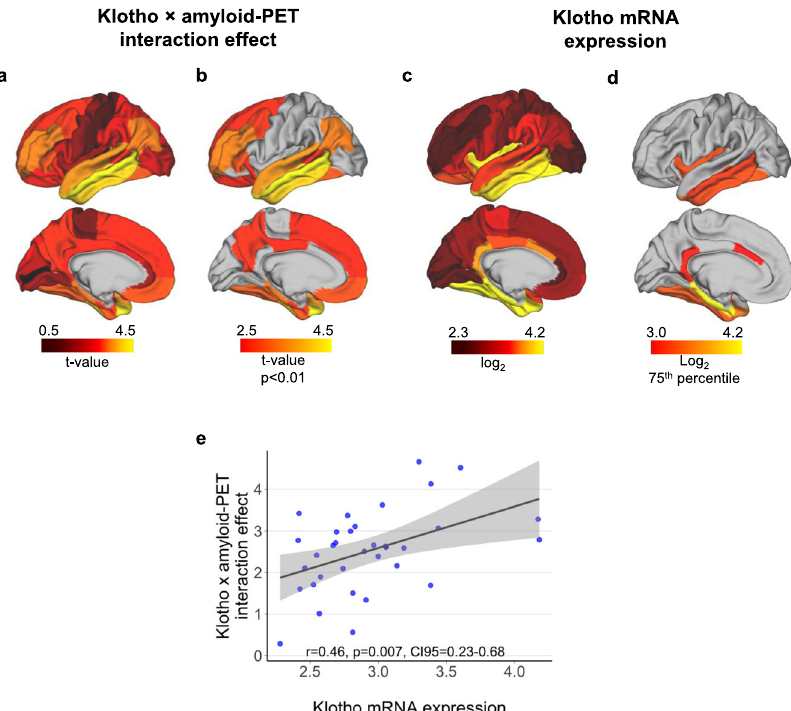
Fig. 2 Spatial patterns of KL-VS het -related attenuation of tau-PET and Klotho mRNA expression. a Surface mapping of the interaction effect between KL-VS het and amyloid-PET levels on tau-PET accumulation within 34 left-hemispheric regions of the Desikan – Killiany atlas. Yellow colors indicate higher t -values re fl ective of a stronger interaction effect (all t -values inverted for illustration purpose; see Supplementary Table 2 for details statistical results). b Thresholded spatial map color-code only regions with a signi fi cant ( p < 0.01, unadjusted for multiple comparisons) KL-VS het × amyloid-PET interaction effect. c Surface mapping of median KL mRNA expression (i.e., log2 derived from the Allen Brain Atlas) within the identical 34 atlas regions. Yellow colors indicate higher KL mRNA expression. d Thresholded spatial maps restricted to regions falling above the 75th percentile of KL mRNA expression. e Scatterplot depicting the association between ROI-based KL mRNA expression and KL-VS het × amyloid-PET interaction effect on regional tau-PET uptake. Statistical results are derived from the Pearson correlation (two-sided). Linear model fi ts are indicated together with 95% con fi dence intervals. Source data are provided as a Source Data fi